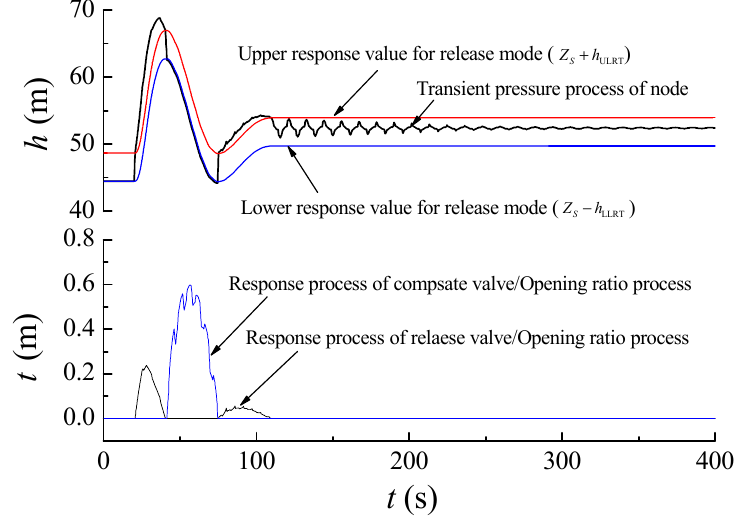
Figure 11. Water hammer control of intelligent surge tank with SAC.